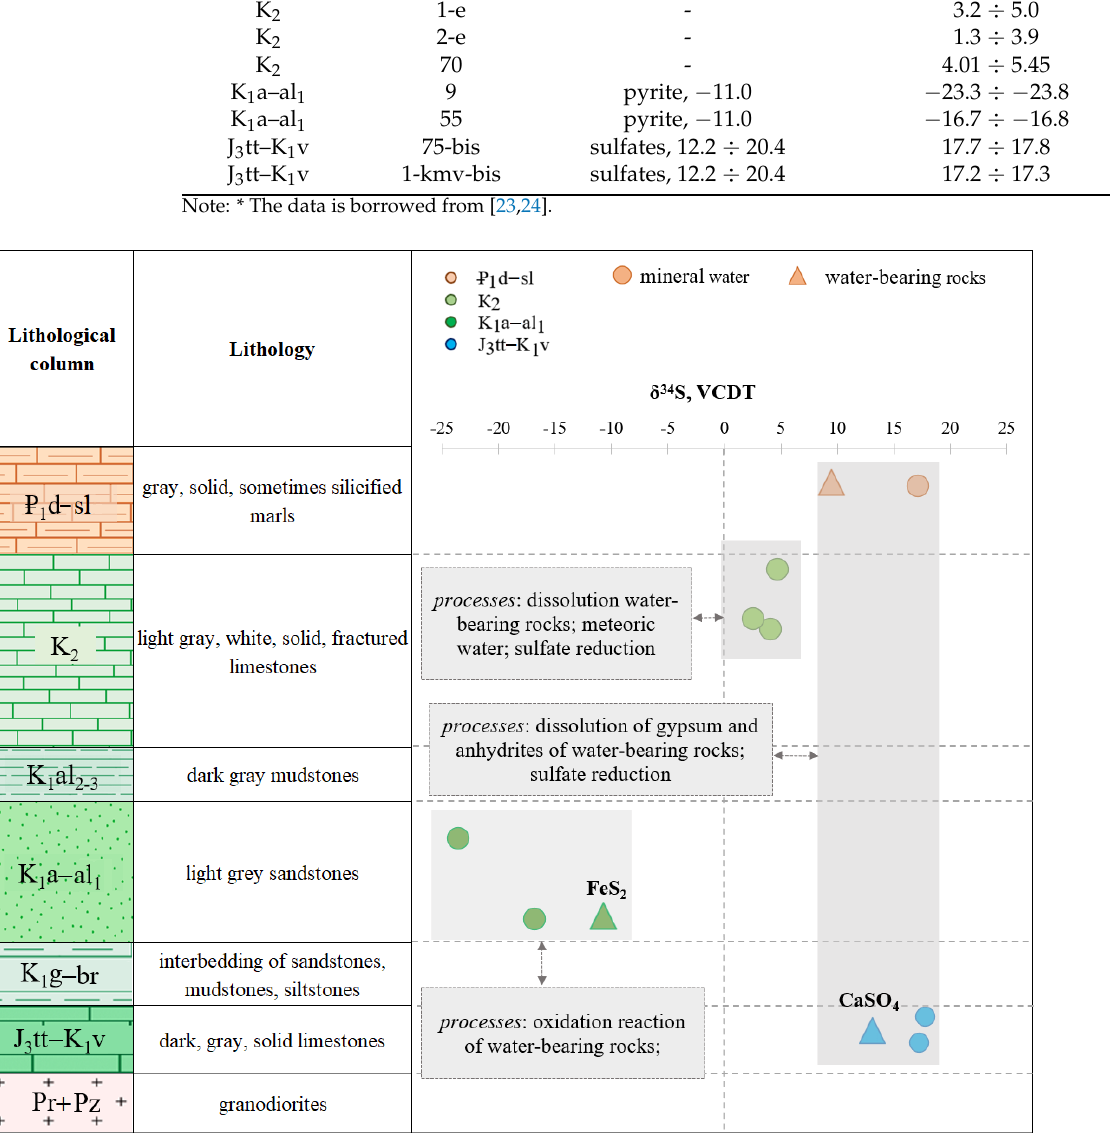
Figure 14. Isotopic composition of sulfur δ 34 S VCDT in mineral water of the Essentuki field. Data on the isotopic composition of sulfur in the rocks are borrowed from [23]. Table 7. Isotopic composition of sulfur in natural mineral water and water-bearing rocks of the Essentuki field.